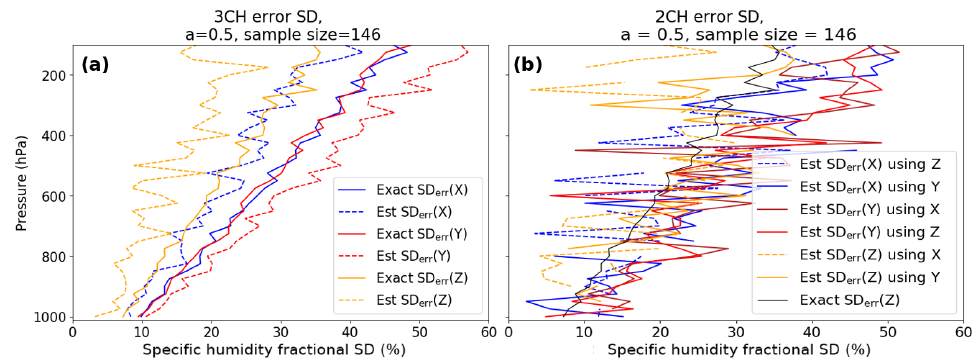
Figure 9. Same as Fig. 8 except for a smaller sample size of 146. All profiles become much noisier, with the 2CH method showing signifi- cantly more noise than the 3CH method.